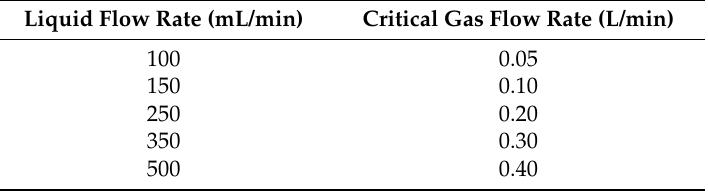
Table 1. Critical gas flow rate at each tested liquid flow rate.